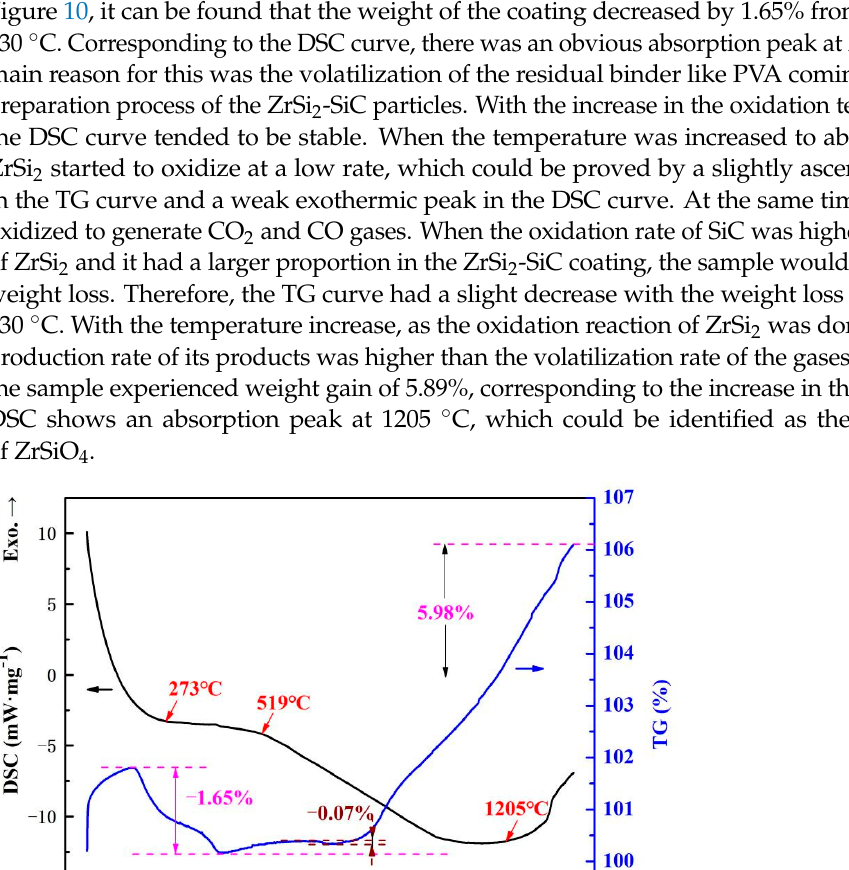
Figure 10. The DSC/TG curves of the ZrSi 2 -SiC spraying powders containing 10 wt.% ZrSi 2